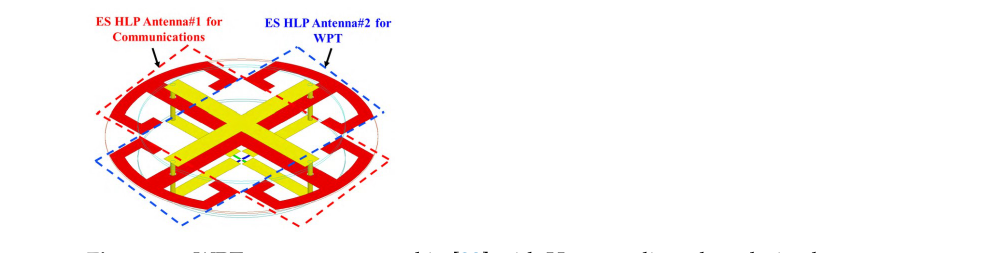
Figure 10. WPT system presented in [33] with Huygens linearly polarized antennas.